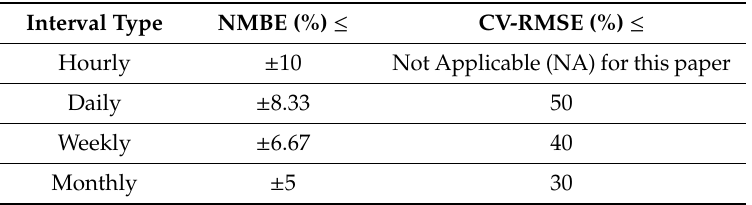
Figure 3. Procedures used for the coefficient checking method for the heating energy use data. Table 3. Thresholds used for the annual heating prediction.